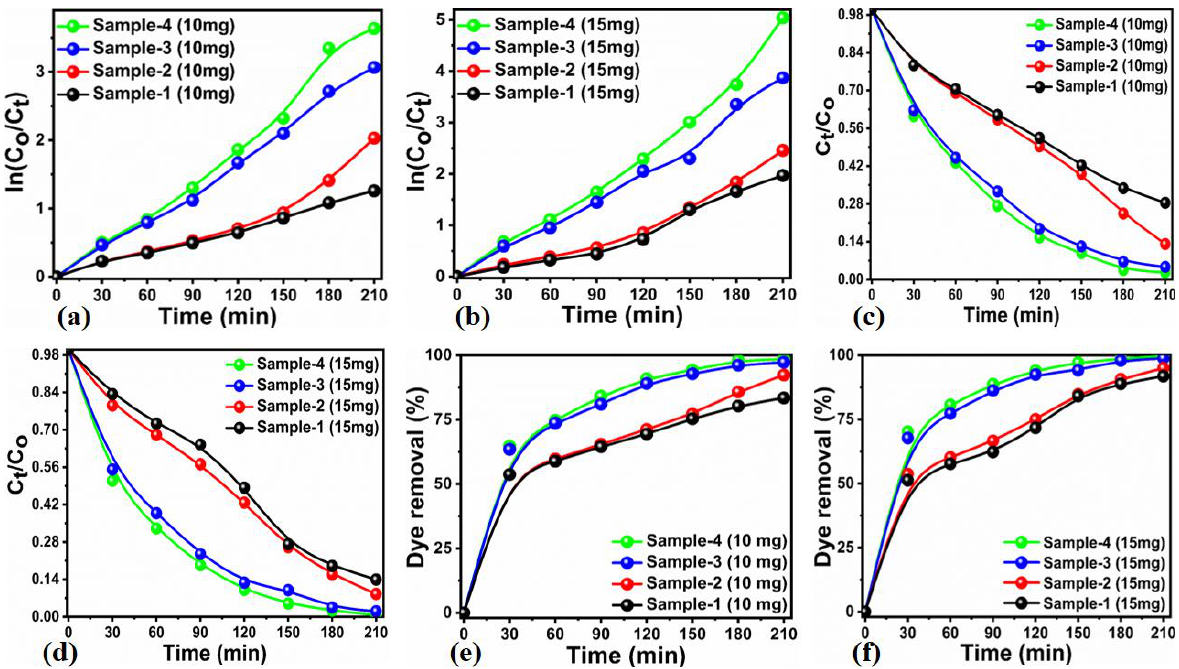
Figure 10. Degradation kinetics of MB using different catalyst doses of 10 and 15 mg in 8.22 × 10 −5 M MB solution under the irradiation of natural sunlight. ( a ) Linear plot of ln( C t / C o ) against 210 min for the catalyst dose of 10 mg, ( b ) Linear plot of ln( C t / C o ) against 210 min for the catalyst dose of 15 mg, ( c ) Linear plot of C t /C o for the catalyst dose of 10 mg, ( d ) Linear plot of C t /C o for the catalyst dose of 15 mg, ( e ) Degradation efficiency of MB solution using catalyst dose of 10 mg, ( f ) Dye removal percentage dose of MB solution using 15 mg of catalyst dose.